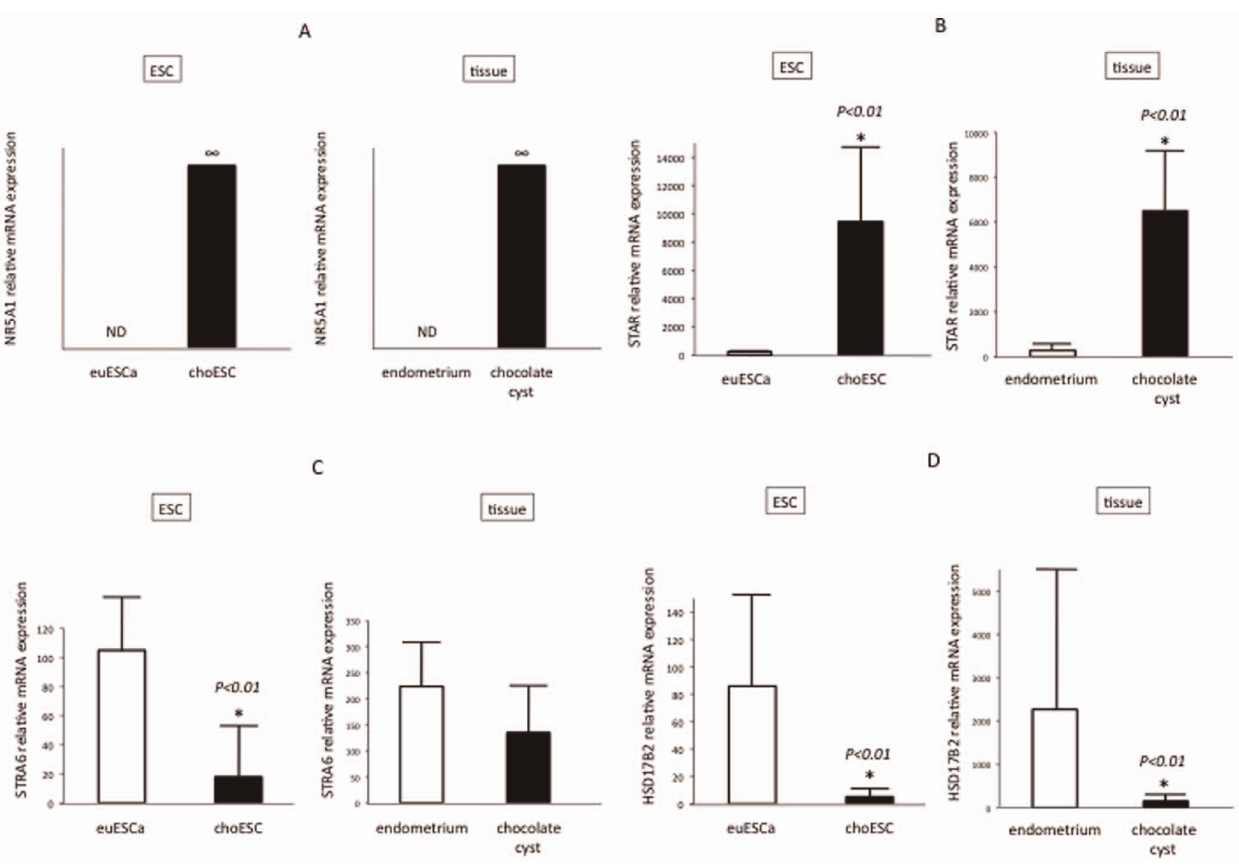
Figure 3. The mRNA levels of NR5A1 (A), STAR (B), STRA6 (C) and HSD17B2 (D) in ESCa, choESC, eutopic endometrium and chocolate cysts. ESCa (n=7), choESC (n=5), eutopic endometria (n=17) and chocolate cysts (n=6) were subjected to total RNA isolation followed by real-time RT-PCR. The relative mRNA expression normalized to that of TBP (an internal control) was calculated. The values are the means 6 SD. *, p , 0.01. ND: not detected.